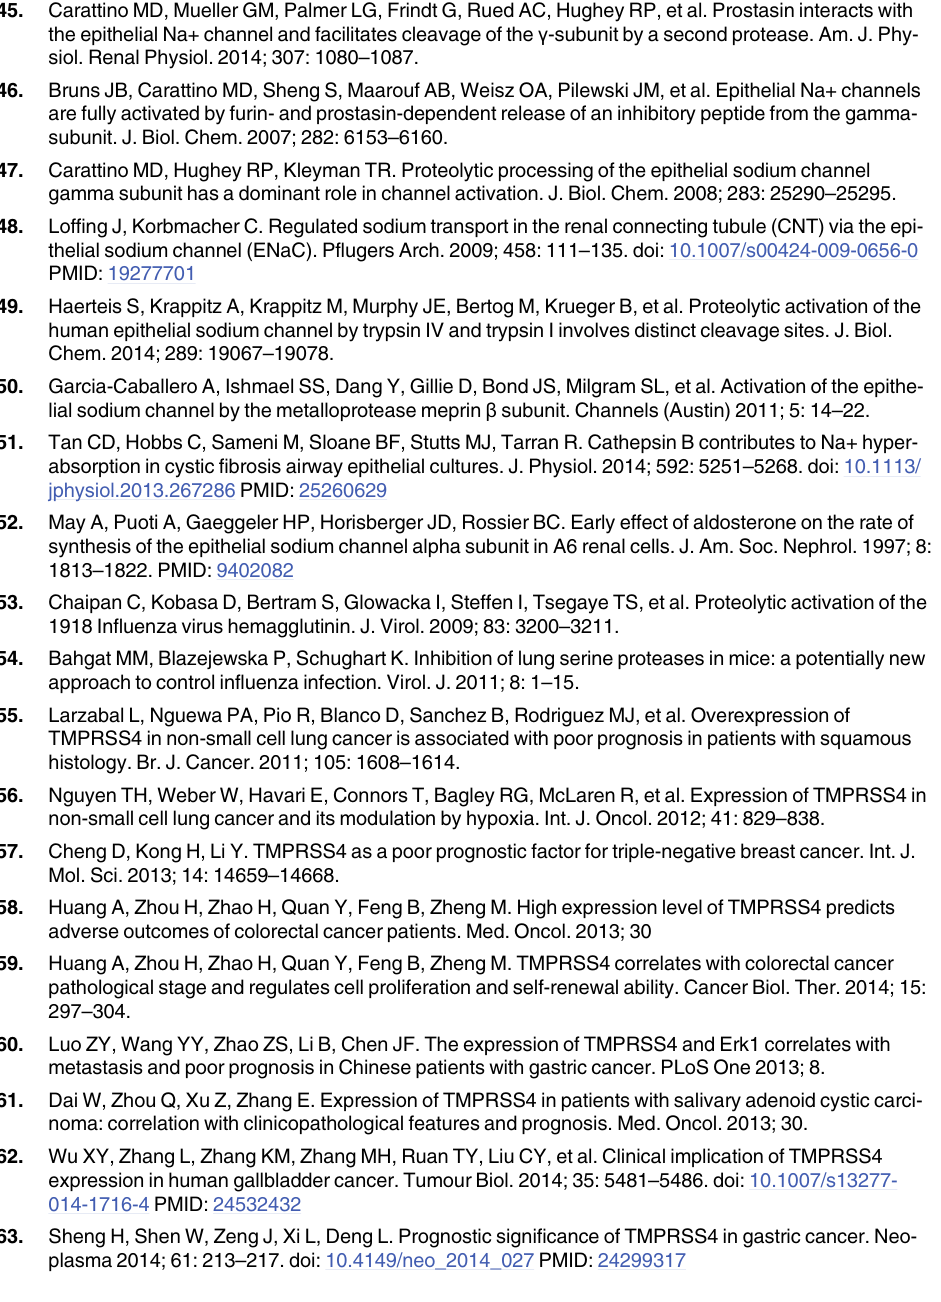
PLOS ONE | DOI:10.1371/journal.pone.0135224 August 26,